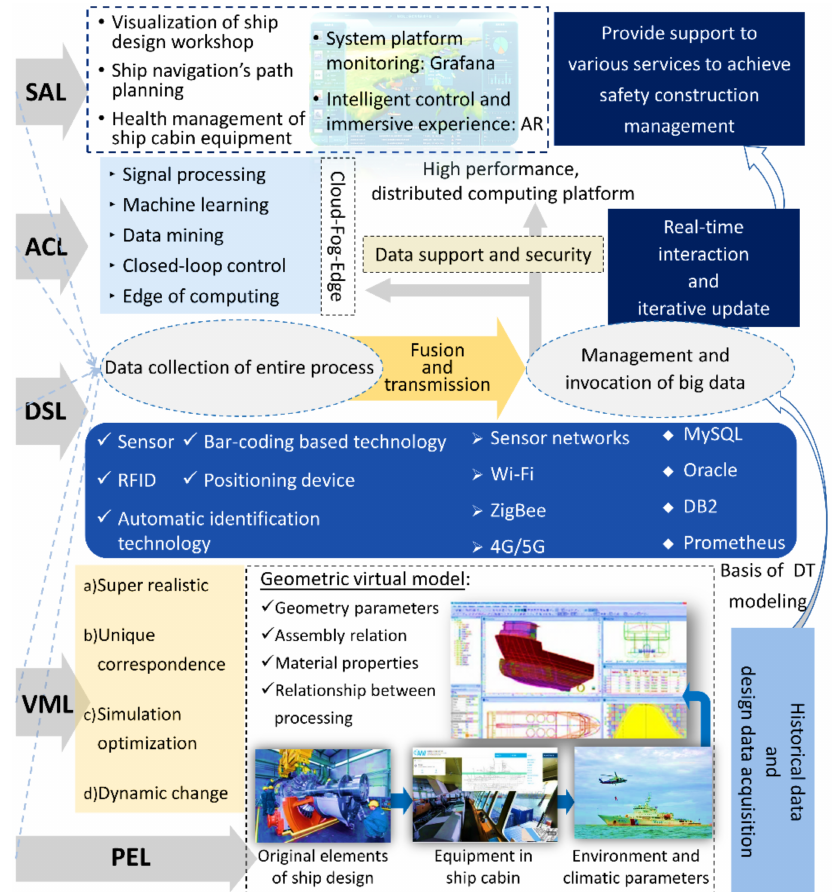
Figure 2. Five-tier framework of process management based on DT-enabled